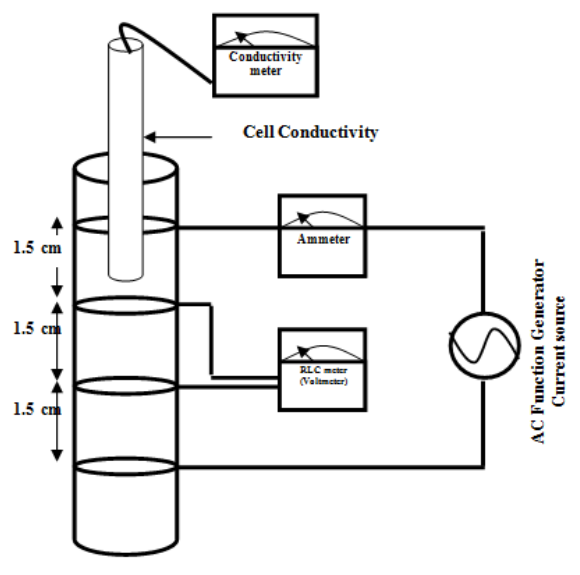
Figure (1) Fabricated cell with electrical